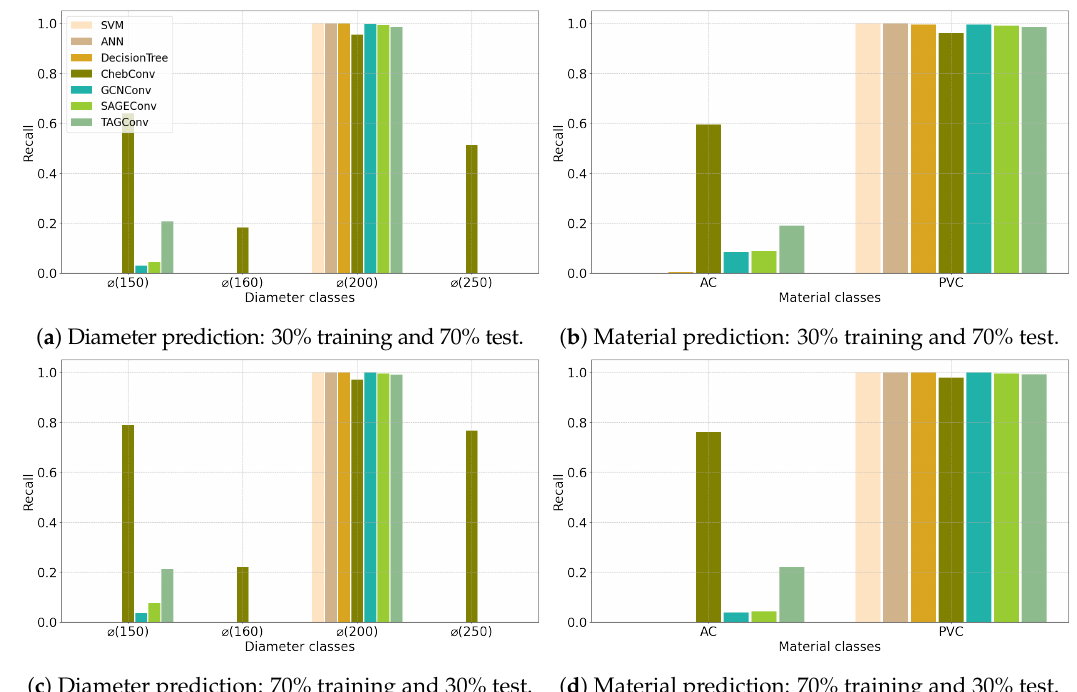
Figure 5. Configuration 1: Diameter and Material prediction for the Angers dataset for each class of the two attributes, evaluated using the Recall